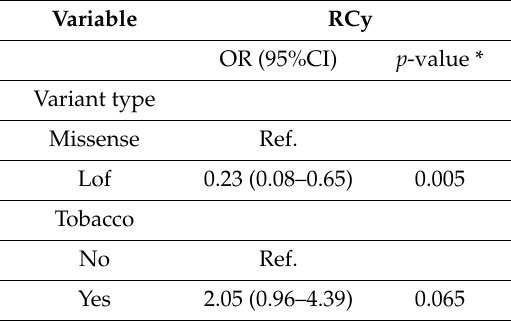
Table 3. Multivariate logistic regression model for Renal Cyst, variant type and tobacco variables.